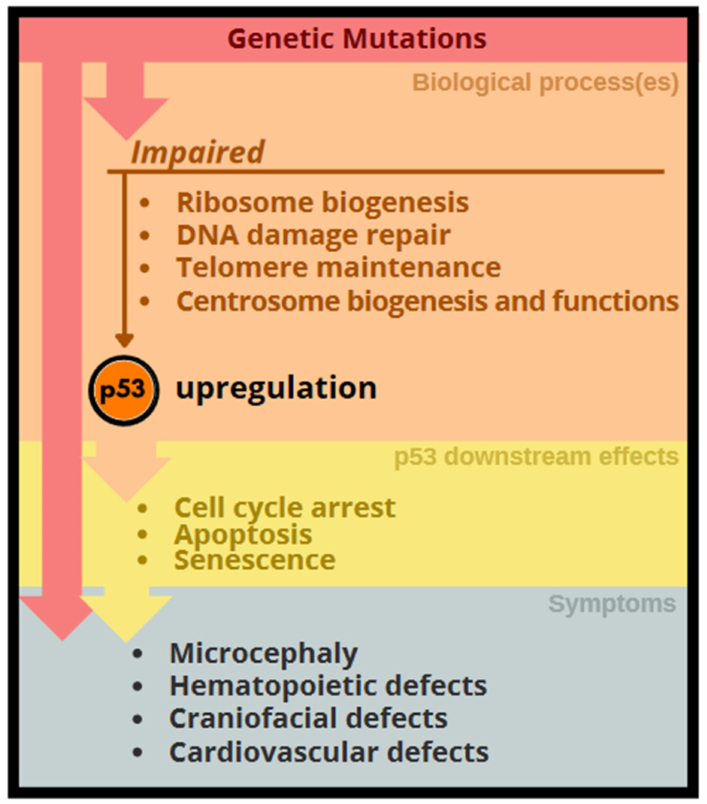
Figure 3. Genetic impact activates the p53 networks resulting in developmental abnormalities. Genetic alterations that disrupt several different cellular processes as depicted lead to upregulation of p53 networks, which leads to stem cell deficiency-associated phenotypic abnormalities. Gene mutations also have direct impact on